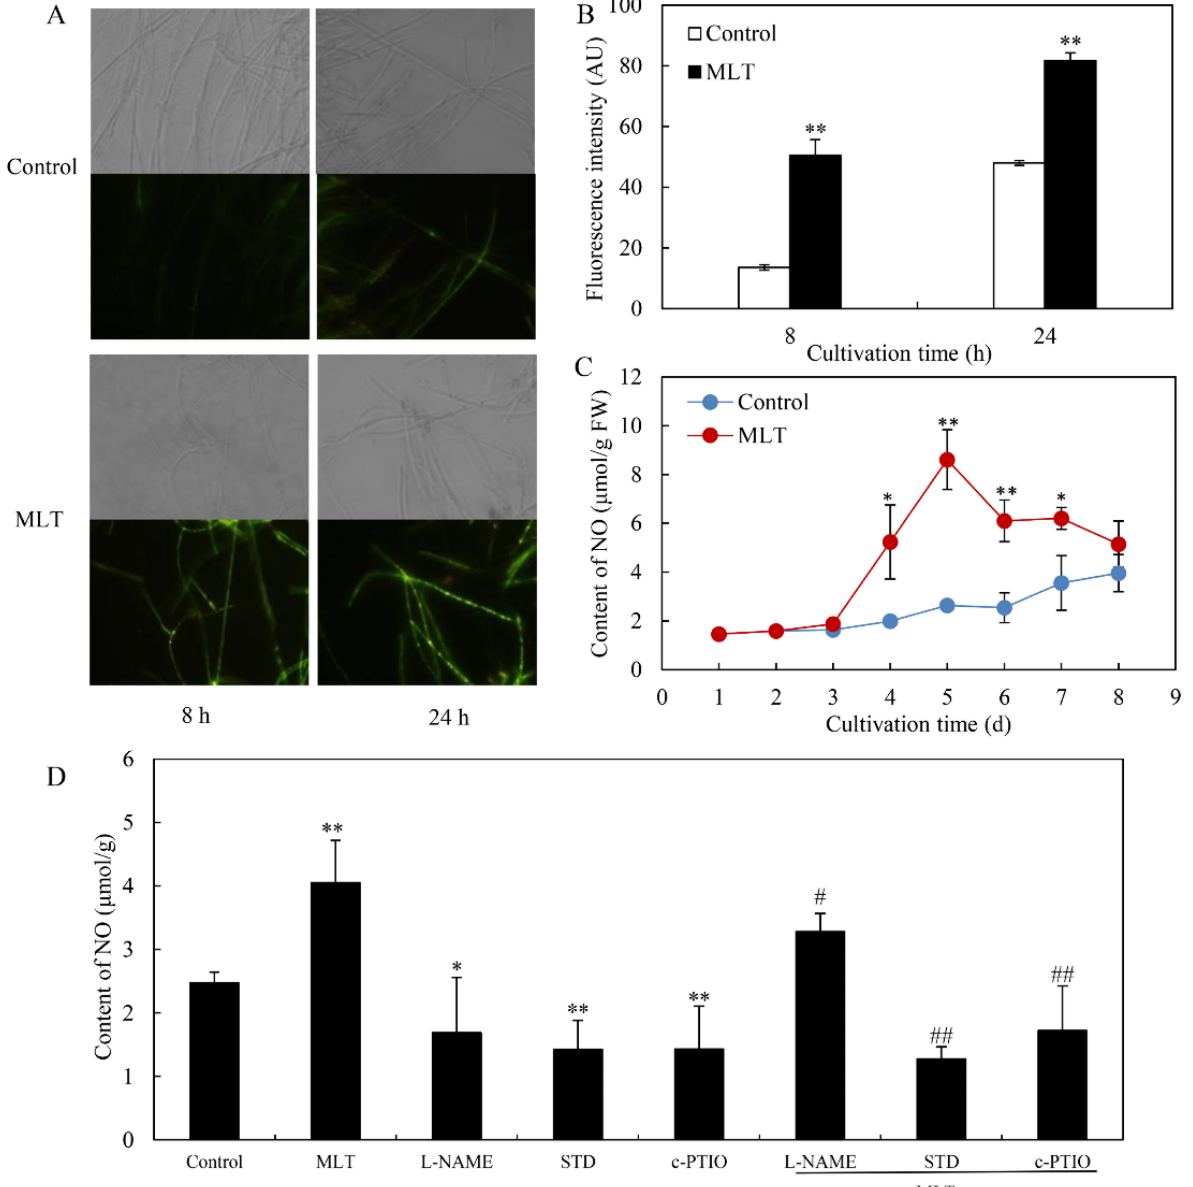
Figure 5. The effect of melatonin (MLT) on NO generation of Shiraia sp. S9 in liquid culture. ( A ) Bright-field image (above) and fluorescence microscopy of DAF-2 DA-stained mycelia (below) (400×) in the cultures. The mycelia were treated with MLT (100.00 μ M) on day 2 of the culture under a light/dark shift (24 h: 24 h) at 28 °C. The relative fluorescence intensity ( B ) and NO contents ( C ) in mycelia. ( D ) Effect of NO inhibitors on MLT-induced NO production. L-NAME (100 μ M), STD (100 μ M) and cPTIO (100 μ M) were added 30 min prior to MLT treatment, respectively. NO content was detected after 24 h of MLT treatment. Values are mean ± SD from three independent experiments (* p < 0.05 and ** p < 0.01 vs. control. # p < 0.05 and ## p < 0.01 vs. MLT treatment).